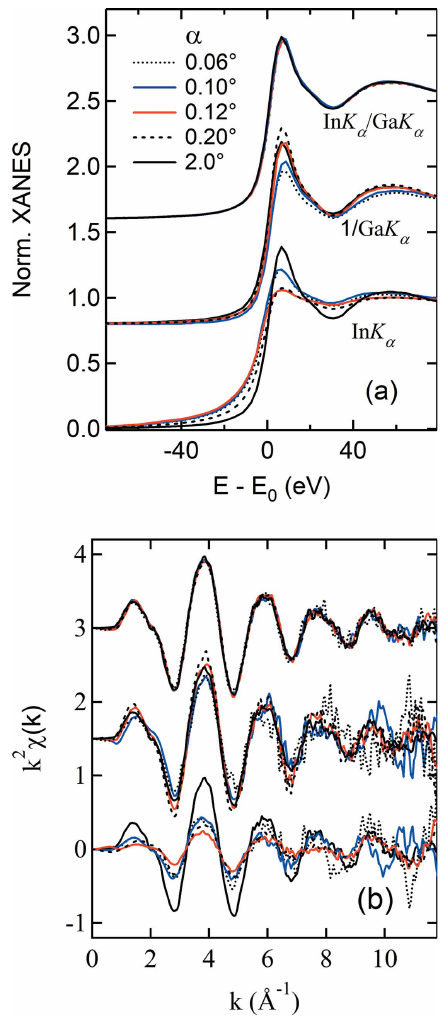
Figure 3 The In K -edge XANES ( a ) and EXAFS ( b ) obtained via three methods: In K (cid:5) , 1/Ga K (cid:5) , and In K (cid:5) /Ga K (cid:5) . See Fig. S4 for the Fourier transforms of